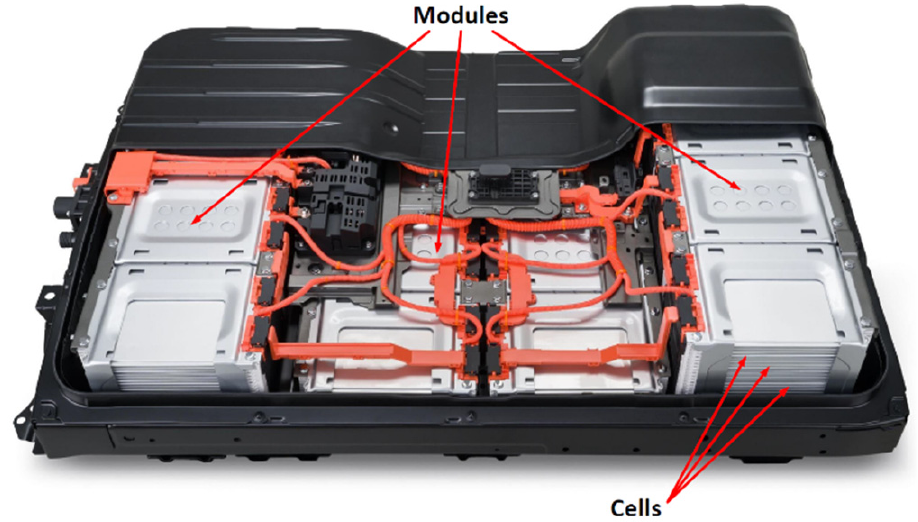
Figure 29. The high-voltage battery components.